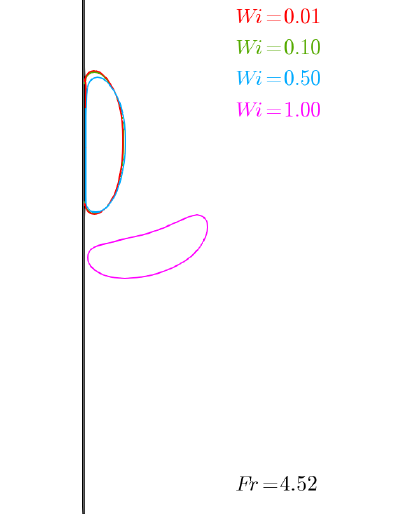
Figure 10. Collision of drops on a vertical wall for fixed values of the Reynolds, Re = 8, and plastic numbers, τ y = 0.4 and the following values of the Weissenberg number, Wi = { 0.01;0.1;0.5;1 } . ( left column ) Fr = 4.52; ( right column ) Fr = 1.13. Dimensionless time, t = 6.